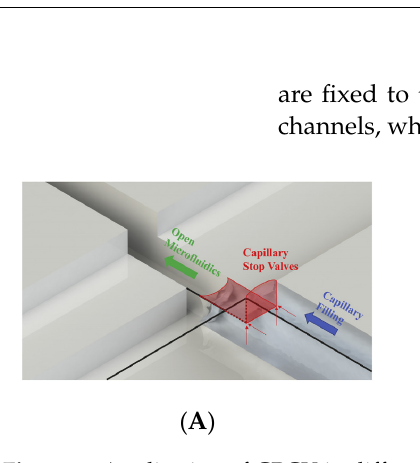
Figure 6. Application of CPCV in different microfluidic scenarios. ( A ) Use of CPCV to quick rivet antibody with open channel. Reprinted with permission from [148]. ( B ) Use of CPCV to build virtual channels. Reprinted with permission from [149]. Copyright 2011 American Institute of Physics.